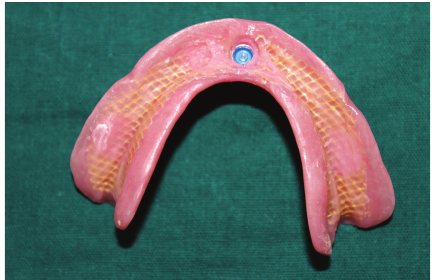
Figure 3: Female housing picked up in the